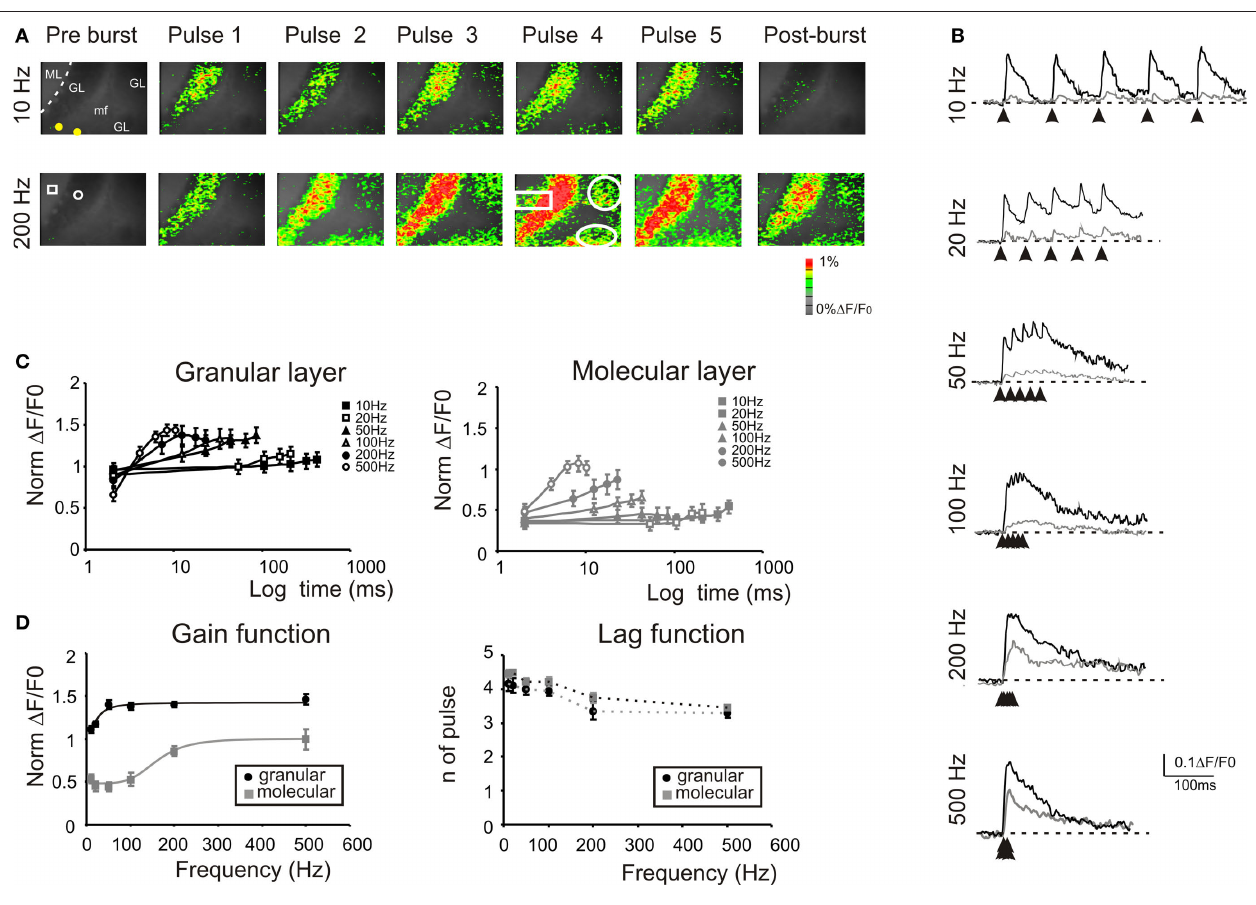
FiGure  | Frequency-dependence of responses to repetitive stimulation. (A) Optical maps were obtained at the peak of responses in 5-pulse bursts delivered to the white matter for two significant frequencies (10 and 200 Hz). Passing from 10 Hz to 200 Hz, there is a progressive intensification of temporal summation in the granular layer which lead to a progressive activation of new recruited areas (white circles). Moreover, the increased stimulation frequency progressively activated the molecular layer (white rectangle) at each pulse of the burst. The post-burst maps were taken 50 ms after the end of the burst where with low-frequency stimulation the activity is almost abolished while, with high frequency there is a persistent signals throughout the granular layer. (B) Traces on the right illustrate the time course of the response in ROIs located in adjacent responding regions of the granular (black) and molecular